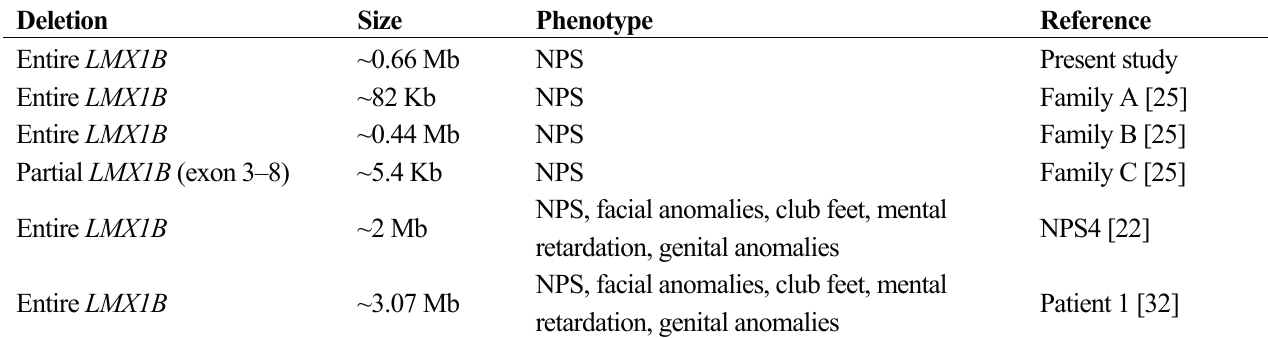
Table 1. LMX1B Deletions